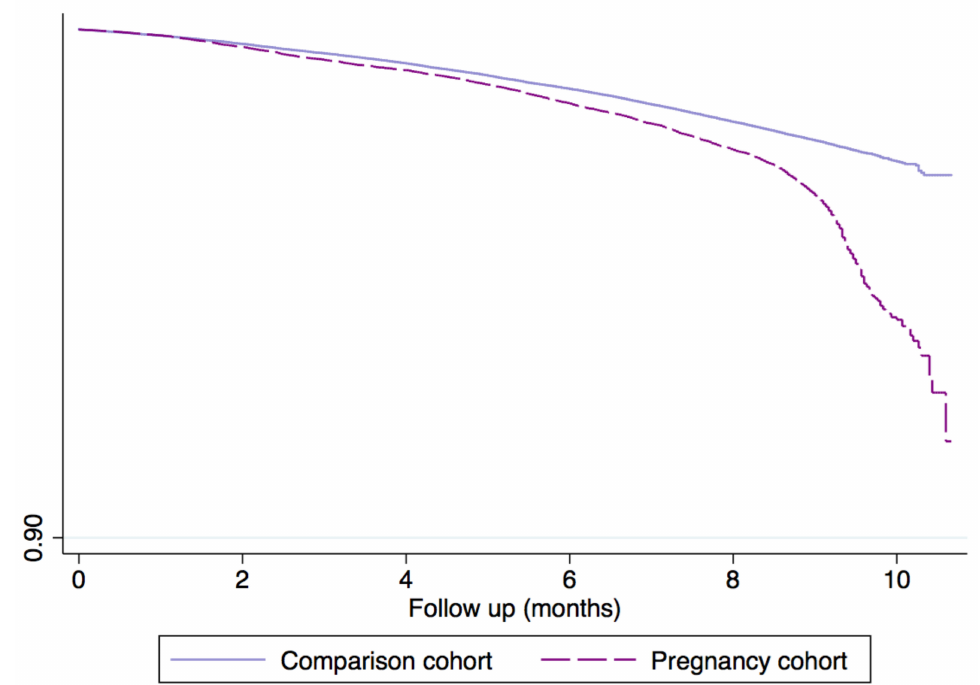
Figure 2. Kaplan–Meier survival estimate showing time to diagnosis of SARS-CoV-2.